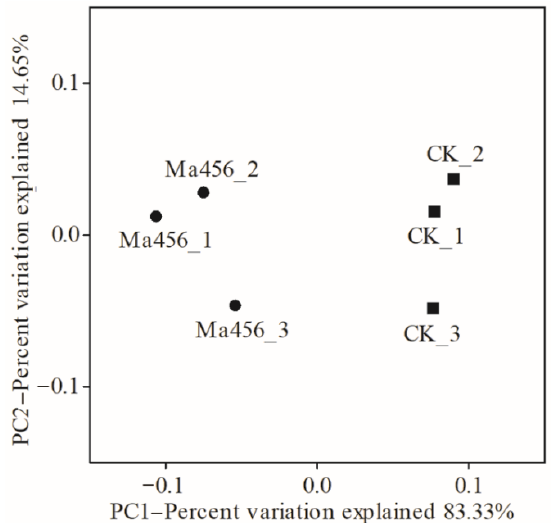
Figure 5. Principal coordinate analysis (PCoA) of beta diversity based on the weighted UniFrac distance metric for gut bacterial communities in the fungus-infected (Ma456) and 0.02% Tween 80-treated (CK) BPH.